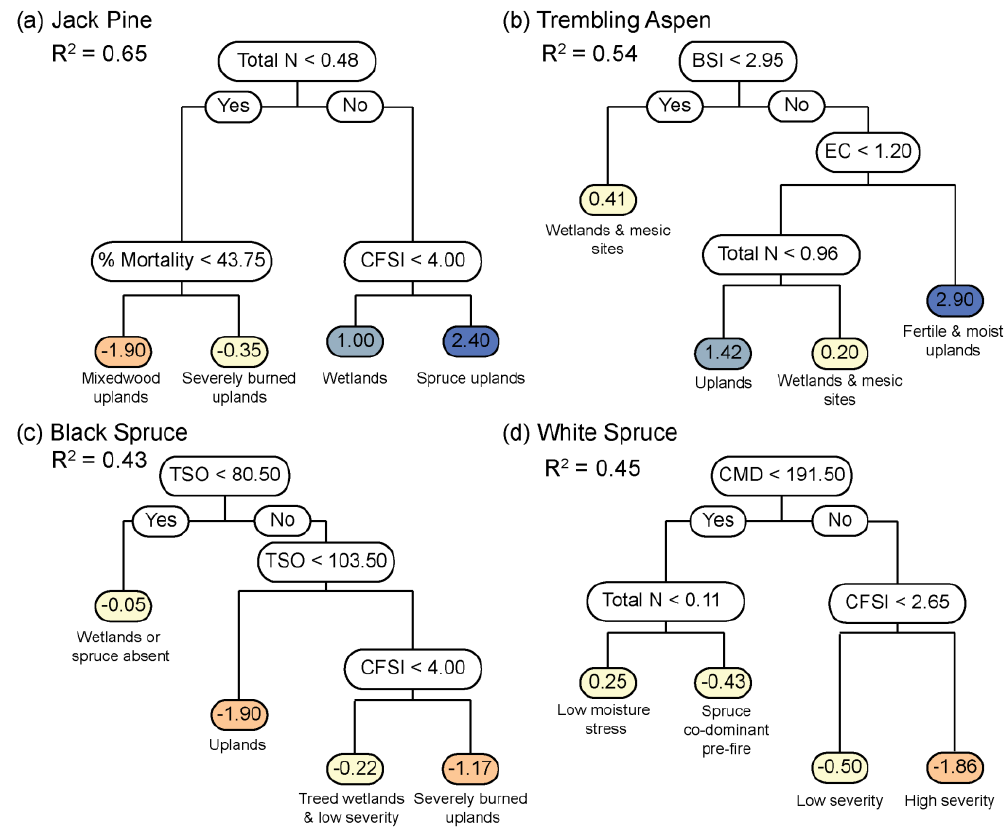
Figure 5. Regression trees of post-fire cohort dominance shifts for ( a ) jack pine; ( b ) trembling aspen, ( c ) black spruce; and ( d ) white spruce. Regression trees were fitted requiring a minimum of five sites per node, and a minimum within-node deviance of 0.05. Light blue terminal nodes indicate increases in dominance post-fire, and dark blue nodes indicate substantial increases in rank dominance ( ≥ 2). Red terminal nodes indicate decreases in dominance. Yellow nodes may be slightly negative or positive, but do not represent strong shifts (description of dominance shift metric in Section 2.3